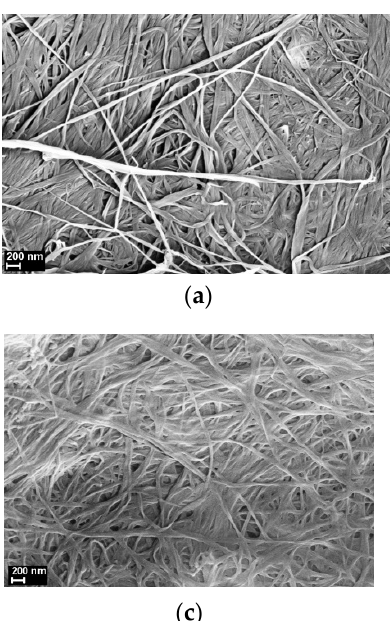
Figure 1. SEM images of the samples studied: ( a ) bare BC; ( b – d ) BC-ceria nanocomposite films con- taining 1 wt.%, 3 wt.%, and 5 wt.% CeO 2 , respectively.